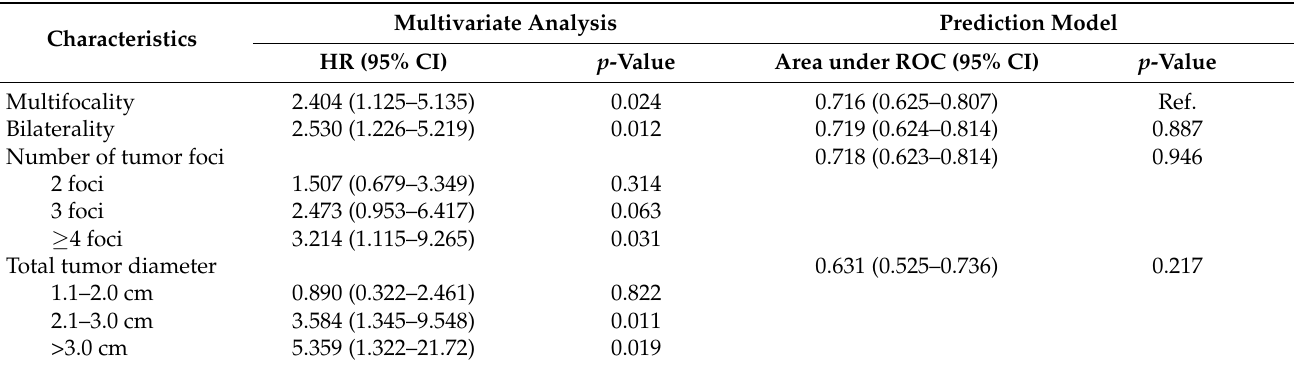
Figure 1. Recurrence-free survival according to the number of tumor foci in patients with PTC. Using these factors, we formulated prediction scores using Cox hazards regression models (Table 4). Predictability as measured by the AUROC of each prediction model indicated that models based on the number of tumors (AUROC of 0.718) and bilaterality (AUROC of 0.719) were more powerful than that based on multifocality (AUROC of 0.716). However, these models based on the number of tumors ( p = 0.946) and bilaterality ( p = 0.887) did not substantially improve the overall predictability of recurrence. The model using TTD (AUROC of 0.631) also showed no significant improvement in predictability of recurrence ( p = 0.217). Table 4. Predictive models for recurrence in patients with papillary thyroid